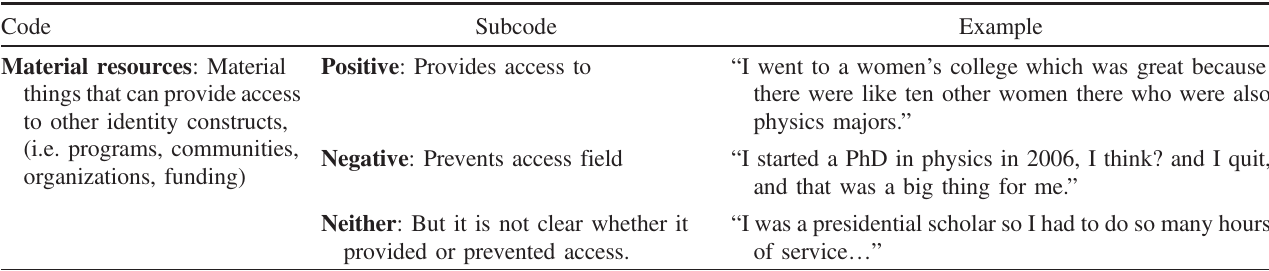
TABLE III. Details of our material resource construct code definitions. This includes the definition of the main construct, as well as the definitions of each subcode and example from the interviews of Cara, Jeff, Cindy, or Owen.